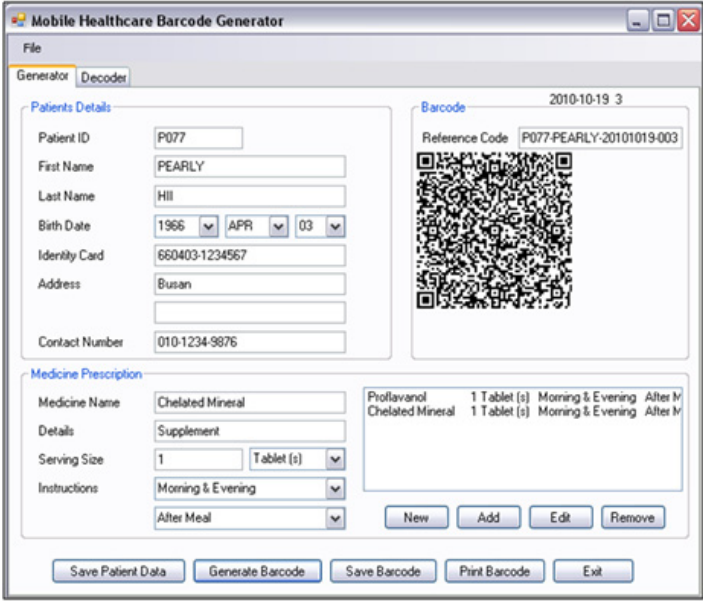
Figure 10. Personalized QR barcode generator in ubiquitous healthcare system.